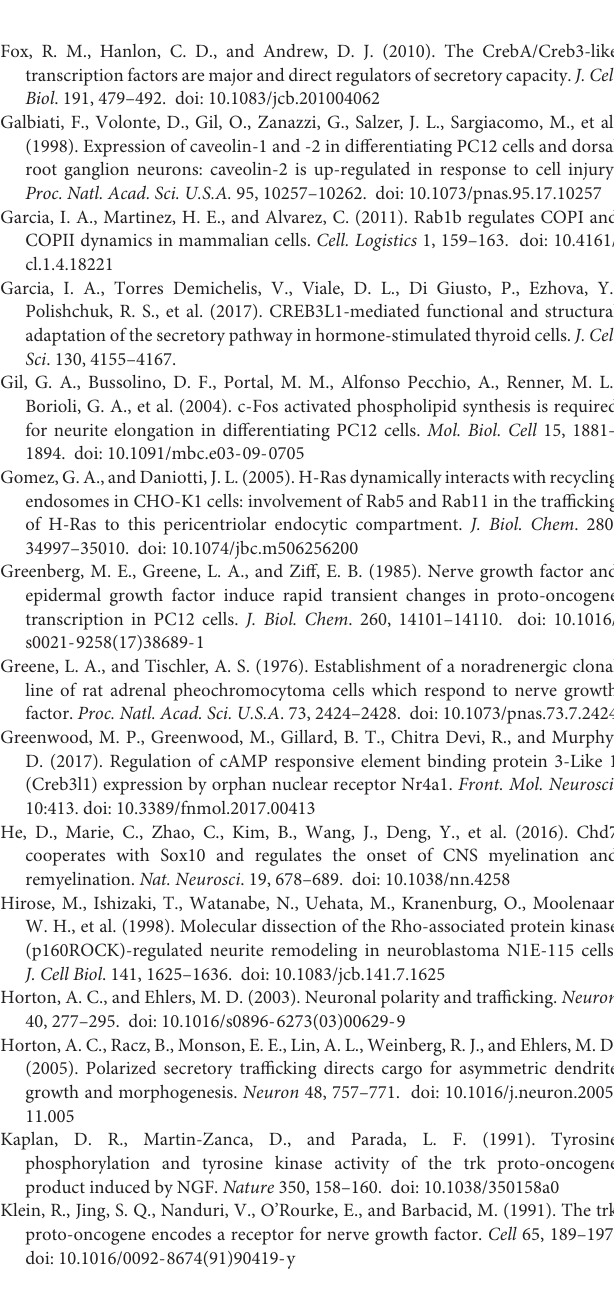
Supplementary Figure 2 | Different shRNAs, shCREB3L2 I, and shCREB3L2 II, elicit similar effects. Representative images of differentiated PC12 cells transfected with shScramble-EGFP or two independent shCREB3L2-EGFP for 48 h before NGF treatment. (A) Representative immunofluorescence staining of CREB3L2 in PC12 cells transfected with shScramble, shCREB3L2 I, or shCREB3L2 II (D3). Fire-LUTs are shown to clearly visualize IF levels. (B) Representative images of PC12 cells transduced with shScramble and shCREB3L2 II and fixed at the indicated day post NGF induction. (C) Quantification of the CREB3L2 fluorescence intensity normalized with the control condition (shScramble). (D,E) Quantification of the total neurite length and the longest neurite. Bars represent the mean ± SEM of three independent experiments carried out in triplicates, and a total of 40 cells were analyzed. Statistical data analysis was performed, using Student’s T -test, considering statistically significant a value of p < 0.05 ( ∗ p < 0.05, ∗∗ p < 0.01; ∗∗∗ p < 0.001). Scale bar: 20 µ m.